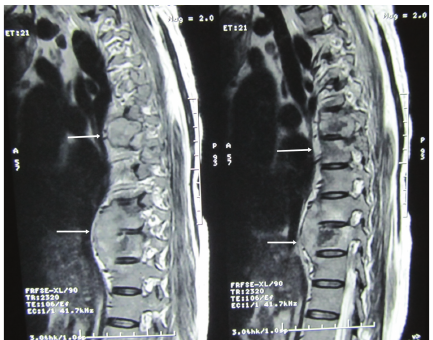
Figure 3: MRI of dorsal spine showing altered marrow signal intensity with abnormal soft tissue lesion involving D6, D7, D9, and D10 vertebrae and intraspinal extension with thecal sac compression at D6